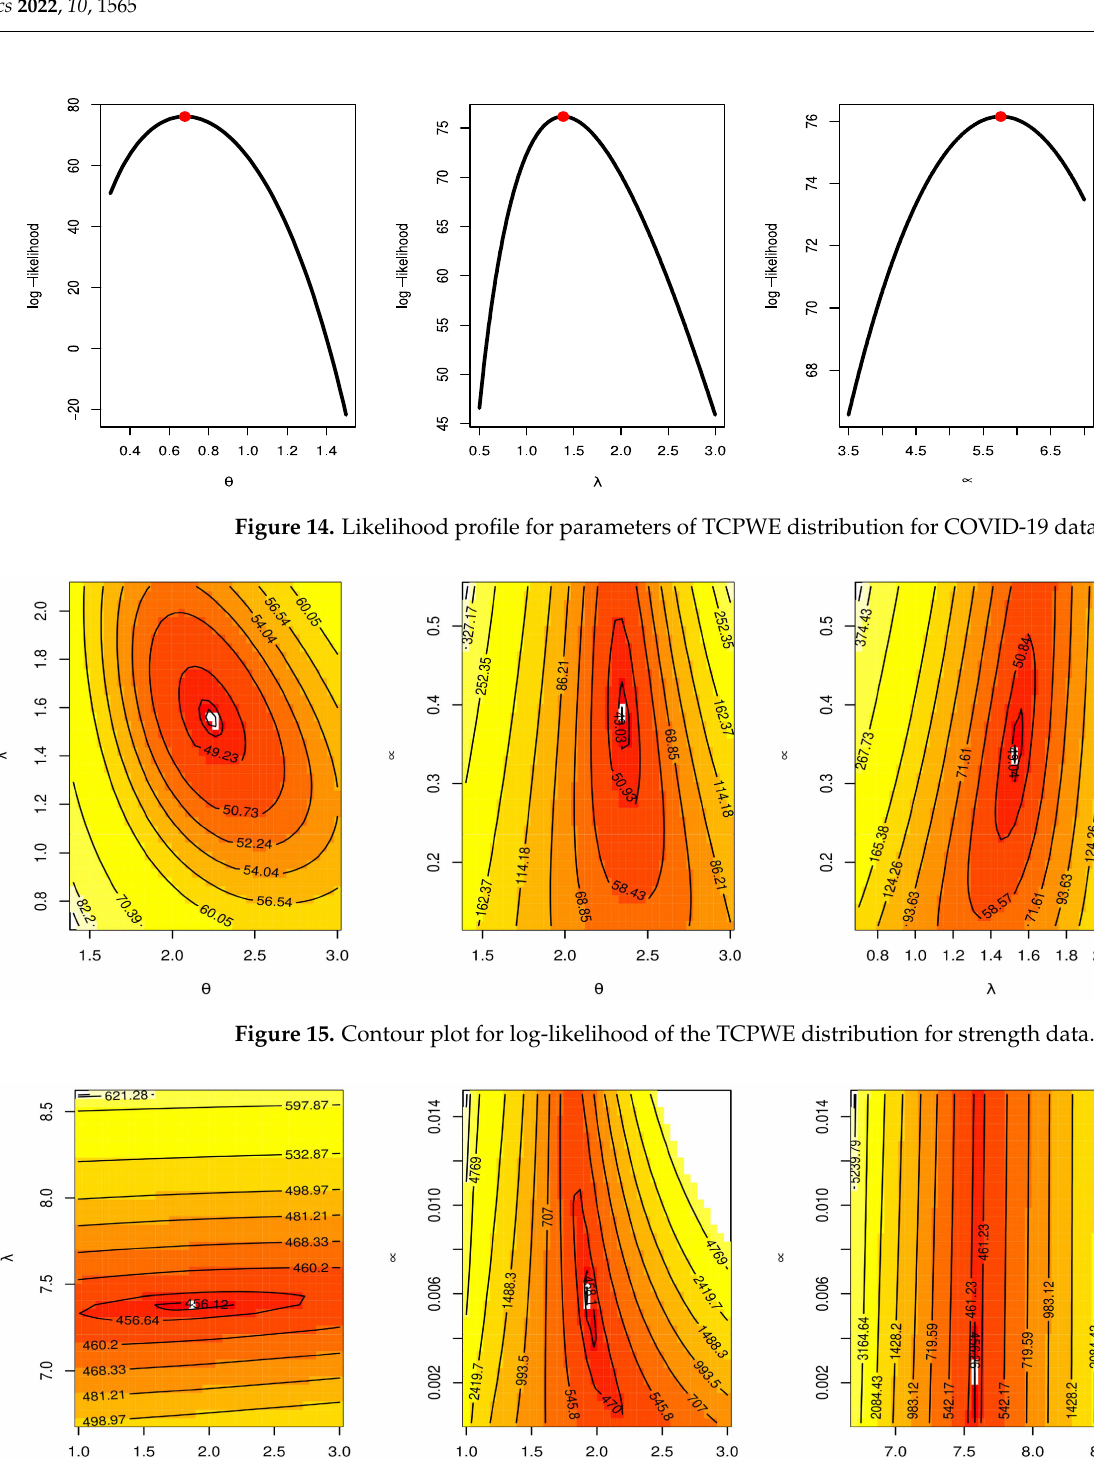
Figure 13. Likelihood profile for parameters of TCPWE distribution for fatigue times.